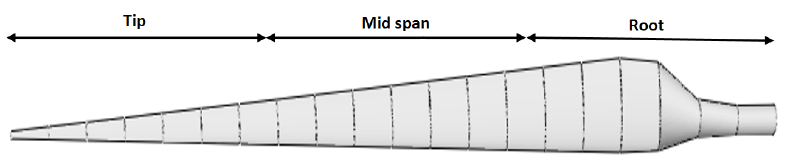
Figure 1. Sections of a wind turbine blade.